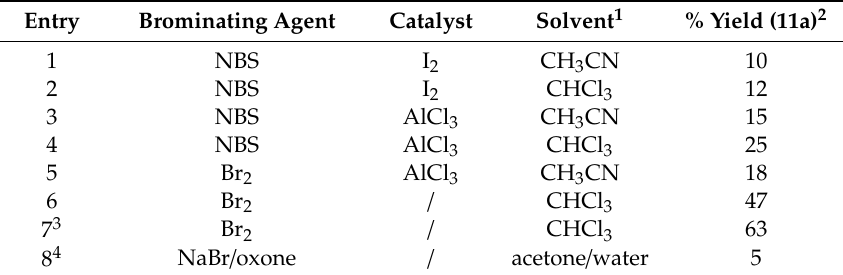
Table 1. Reactions for bromination of 10a.